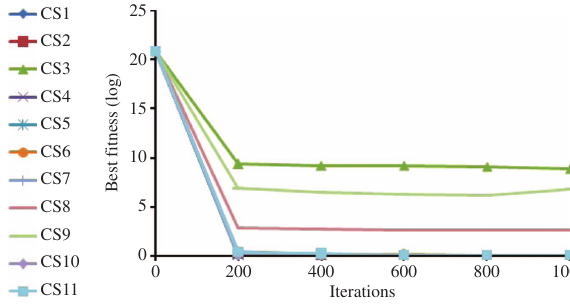
Figure 5: Convergence Trend of f 8 .